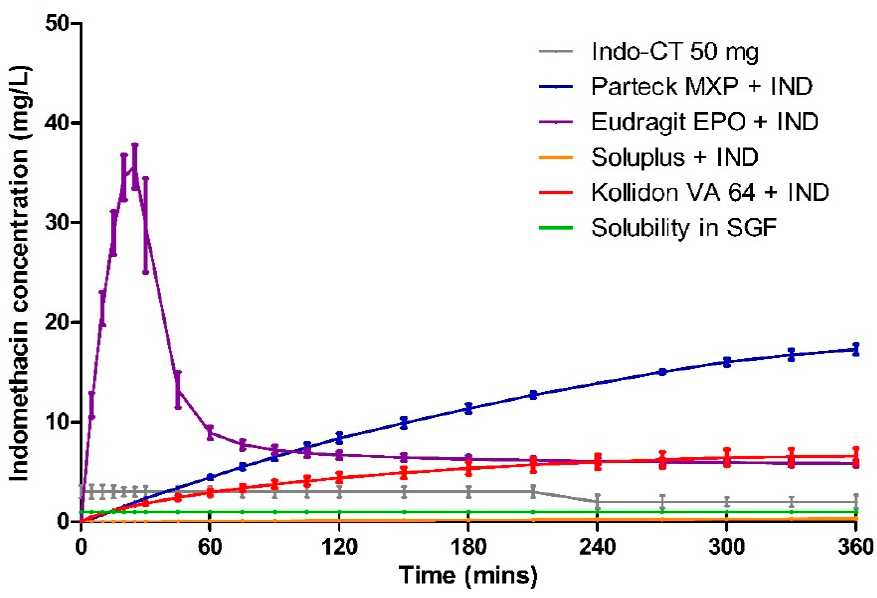
Figure 9. Dissolution testing for 8 mm VCM discs in simulated gastric fluid.